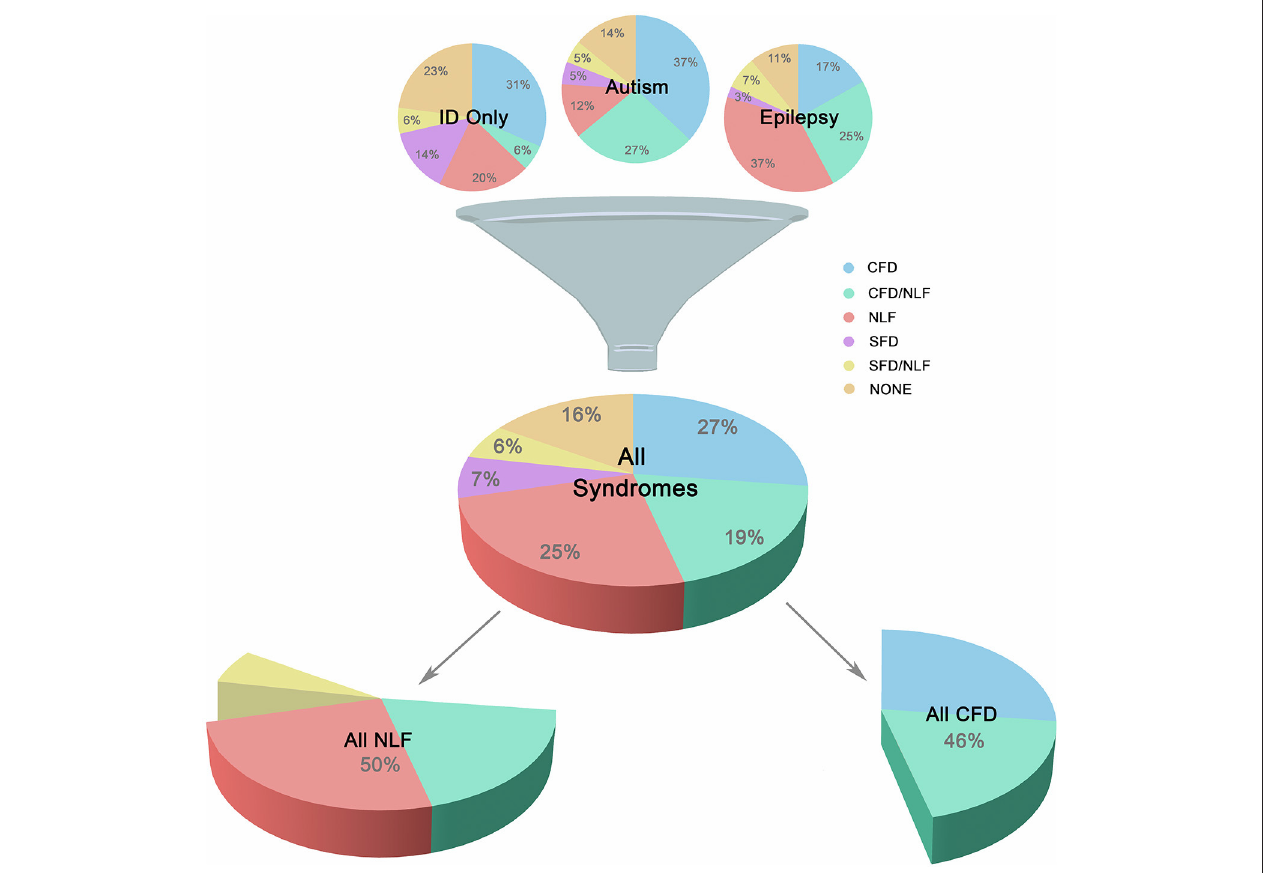
FIGURE 1 | Major Subgroups. Illustration showing breakdown of the three main groups (autism, epilepsy, and ID only) into smaller clinically-related subgroups. Subgroups were defined according to the presence of complex facial dysmorphia (CFD), neurodegenerative-like features (NLF), simple facial dysmorphia (SFD), or a lack of these same features (i.e., “none”). As shown in the lower portion of the image, CFD, and NLF overlapped ∼ 20% of the time, although analyses indicate no clear relationship between the two sets of features, suggesting possible genetic pleiotropy when comorbid.